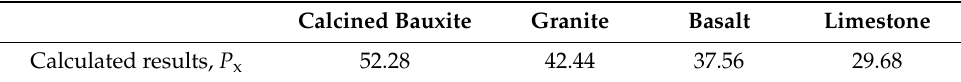
Table 5. Calculated P x values for the four aggregates.